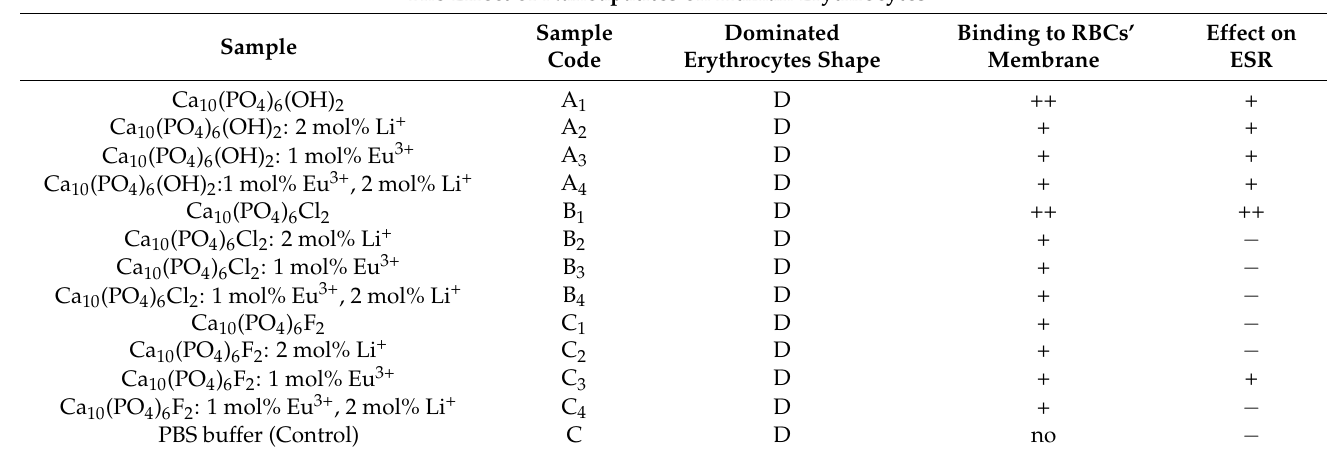
* Presented values are the mean ± SD of three independent experiments with erythrocytes from different donors; abbreviations: D— discocytes (normal cells, such as control cells). (+)—weak effect observed, (++)—strong effect observed, (-)—no effect observed; ESR— erythrocyte sedimentation rate.